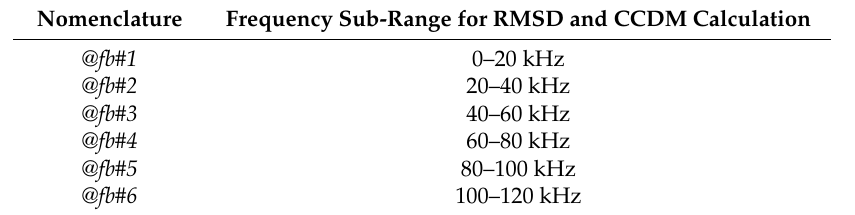
Table 2. Selected frequency sub-ranges for damage metrics calculation. (RMSD: root mean square deviation; CCDM: the correlation coefficient deviation metric)